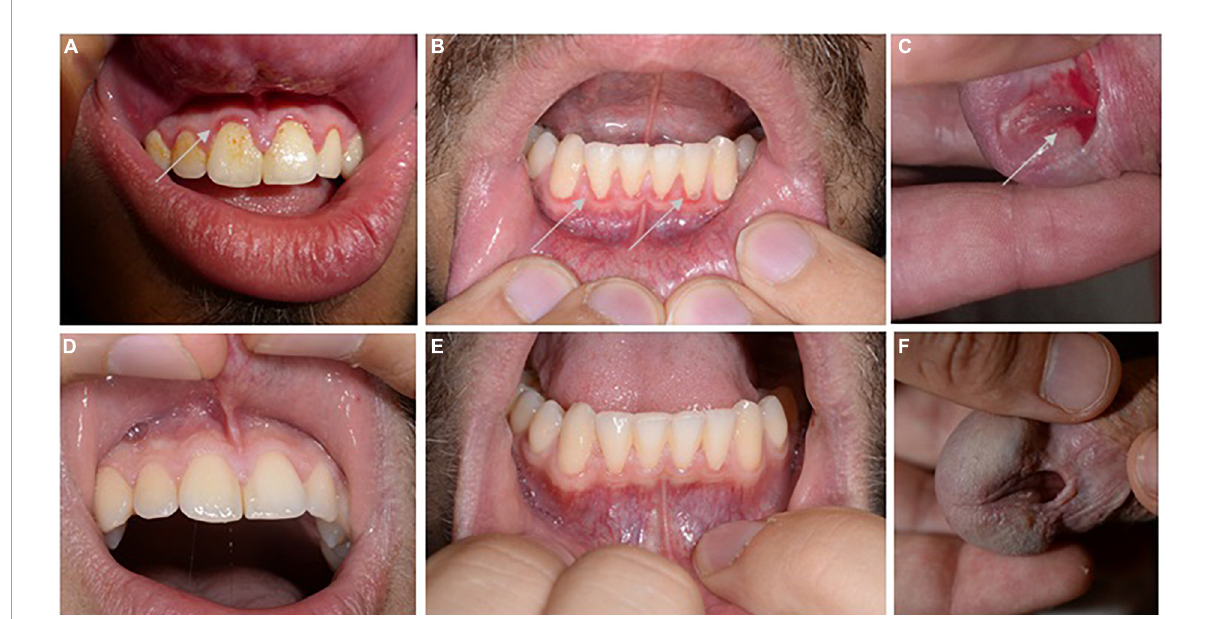
FIGURE1 Clinical picture. Discrete swelling and erosions (highlighted by arrows) around the gingival fringes of the upper (A) and lower tooth space (B) , as well as a painful ulcer at the urethral entrance were identified at initial presentation (C) . Inconspicuous mucosal findings of the upper gingiva (D) and lower gingiva (E) and urethral outlet (F) followed initiation of therapy with prednisolone combined with